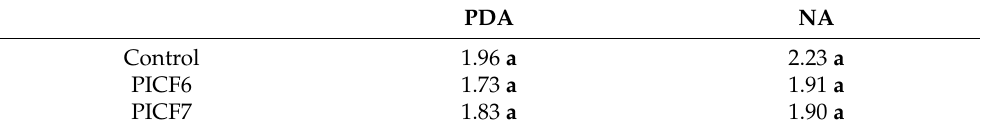
Table 3. Effect of volatile organic compounds (VOCs) produced by Pseudomonas sp. PICF6, Pseu- domonas simiae PICF7 on the mycelial growth of Verticillium dahliae V937I evaluated using the Two Clamp VOCs Assay (TCVA). PDA NA Control 1.96 a 2.23 a PICF6 1.73 a 1.91 a PICF7 1.83 a 1.90